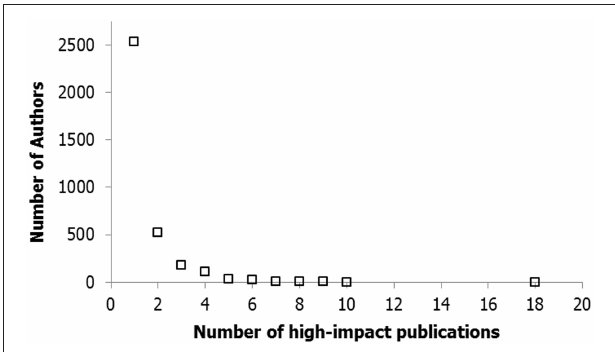
FIGURE 3 | Product distributions of the number of scientific articles in leading journals in economics vs. the number of authors who published that number of articles, after Sutter and Kocher